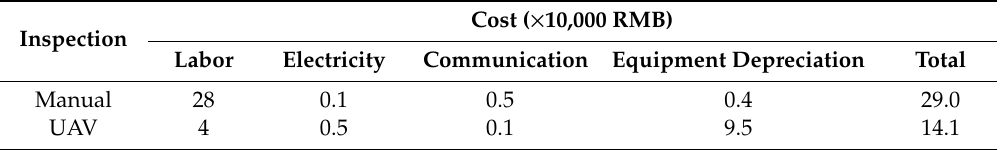
Table 6. The inspection cost of 50 km of oil pipeline per year using two di ff erent methods.